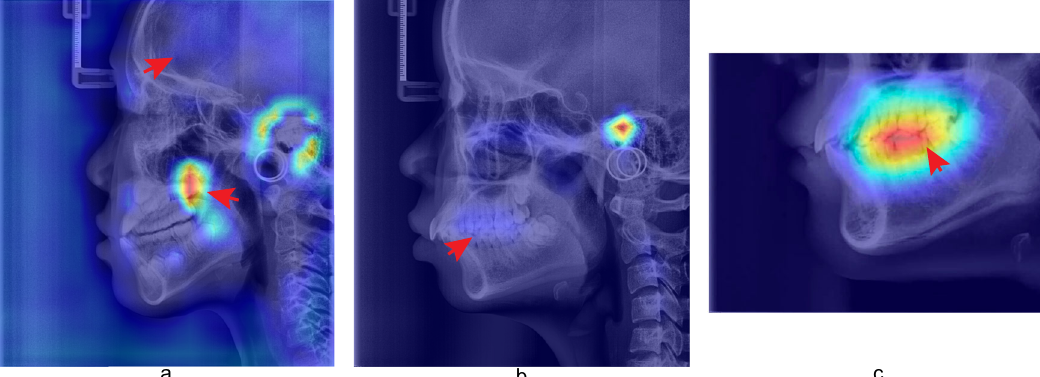
Fig. 7 Examples of regions in ARDA map showing ageing salience that can be cross validated with existing research. a The LCR image and corresponding ageing salience map of a 7-year-old subject, which represents the ARDA distribution on LCR image in the period from 4 to 7 years of age. The arrows from top to bottom point to the cranial region, and posterior margin of the maxilla, respectively. b The LCR image and corresponding ageing salience map of an 18-year-old subject, which represents the ARDA distribution on LCR image in the period from 8 to 18 years of age. The arrow points to the upper and lower dentition. c Tooth region of LCR image and corresponding ageing salience map of a 18-year-old sample, which represents the ARDA distribution on the teeth region of LCR image in the period from 8 to 18 years of age. The arrow points to the upper and lower